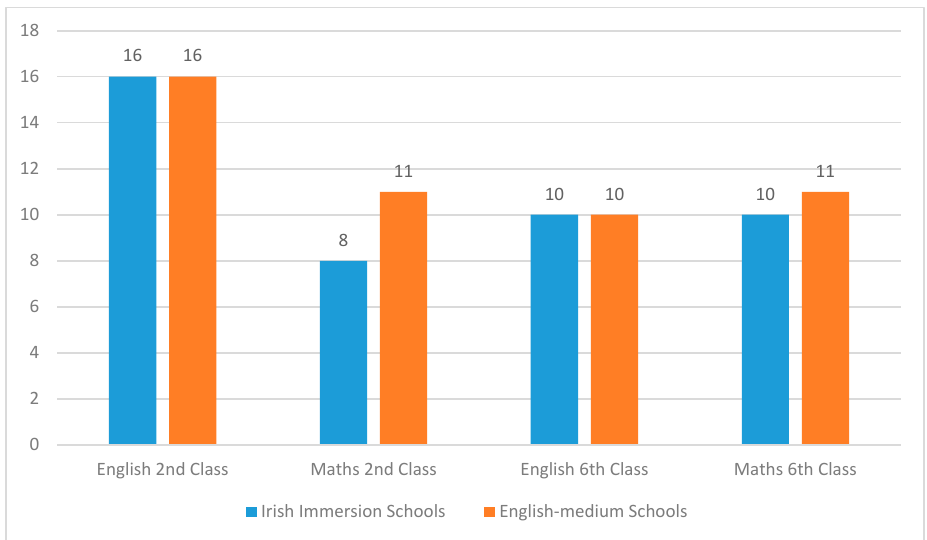
Figure 1. Comparison of the percentage of children attending learning support in Irish immersion and English-medium schools (Adapted from: Shiel et al. 2011, p.